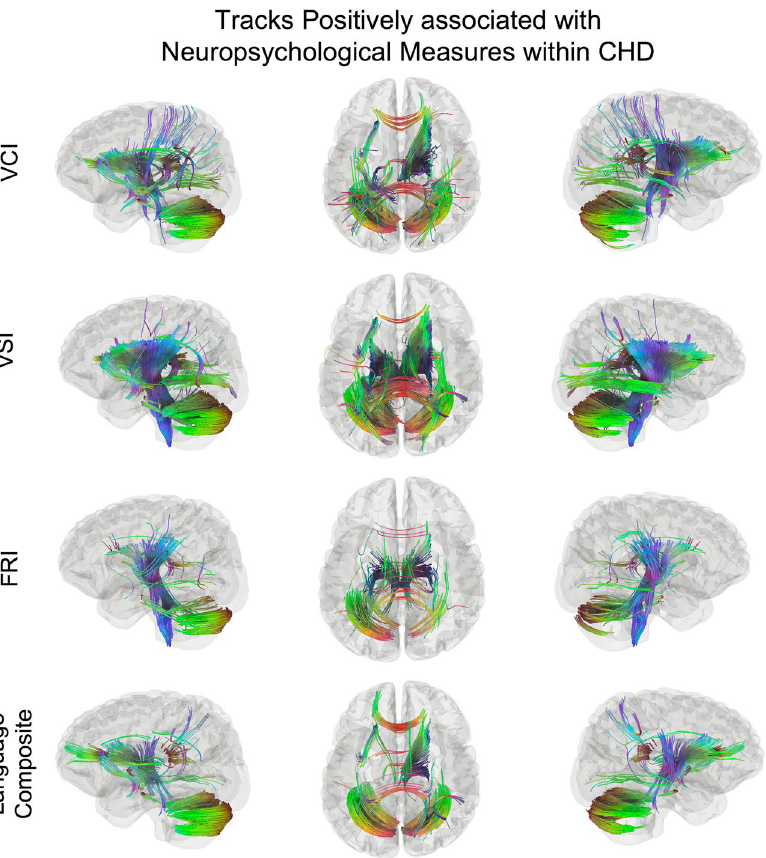
Figure 2. Tracks positively associated with VCI (FDR = 0.029), VSI (FDR = 0.038), FRI (FDR = 0.019), and Language Composite (FDR = 0.033). Tracts associated with VCI include forceps minor and splenium of the CC, bilateral cerebellar tracts, left UF, and bilateral corticothalamic tracts (top row). Tracts correlated with VSI include bilateral CST, left posterior AF, and bilateral posterior portions of the IFOF (second row). Unique tracts related to FRI include bilateral cinguli and tempro-parietal tracts (third row). Tracts associated with Language composite (last row) are nearly identical to those related to VCI (first